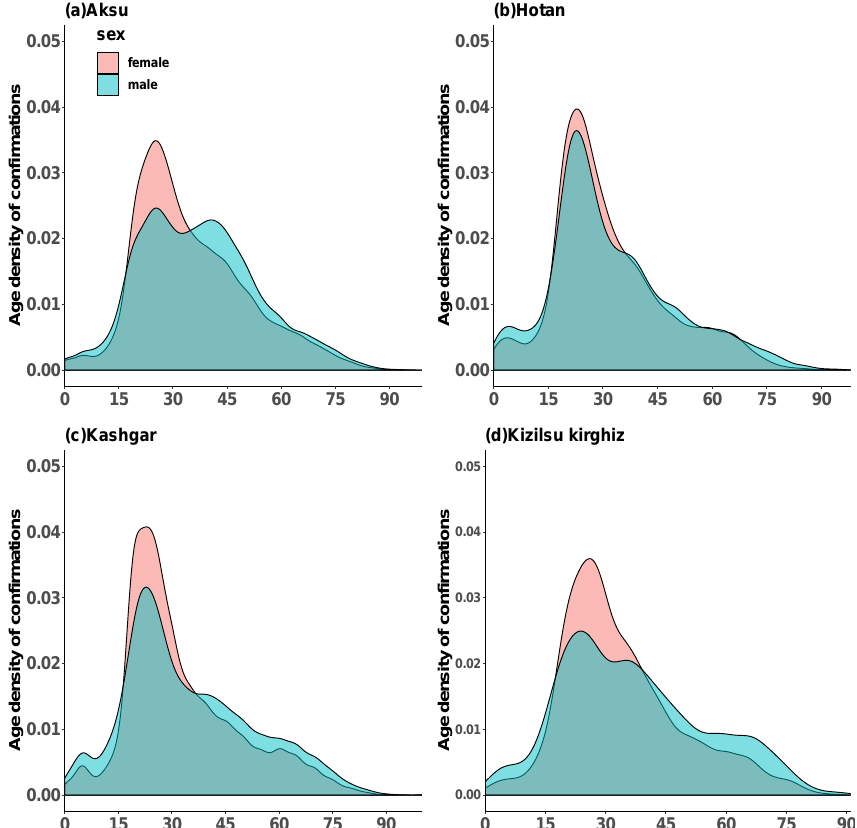
Figure 3. Age densities of HB in women and men in four regions of Xinjiang from 2005 to 2017. In each group, blue and red lines represented the age densities of HB in men and women